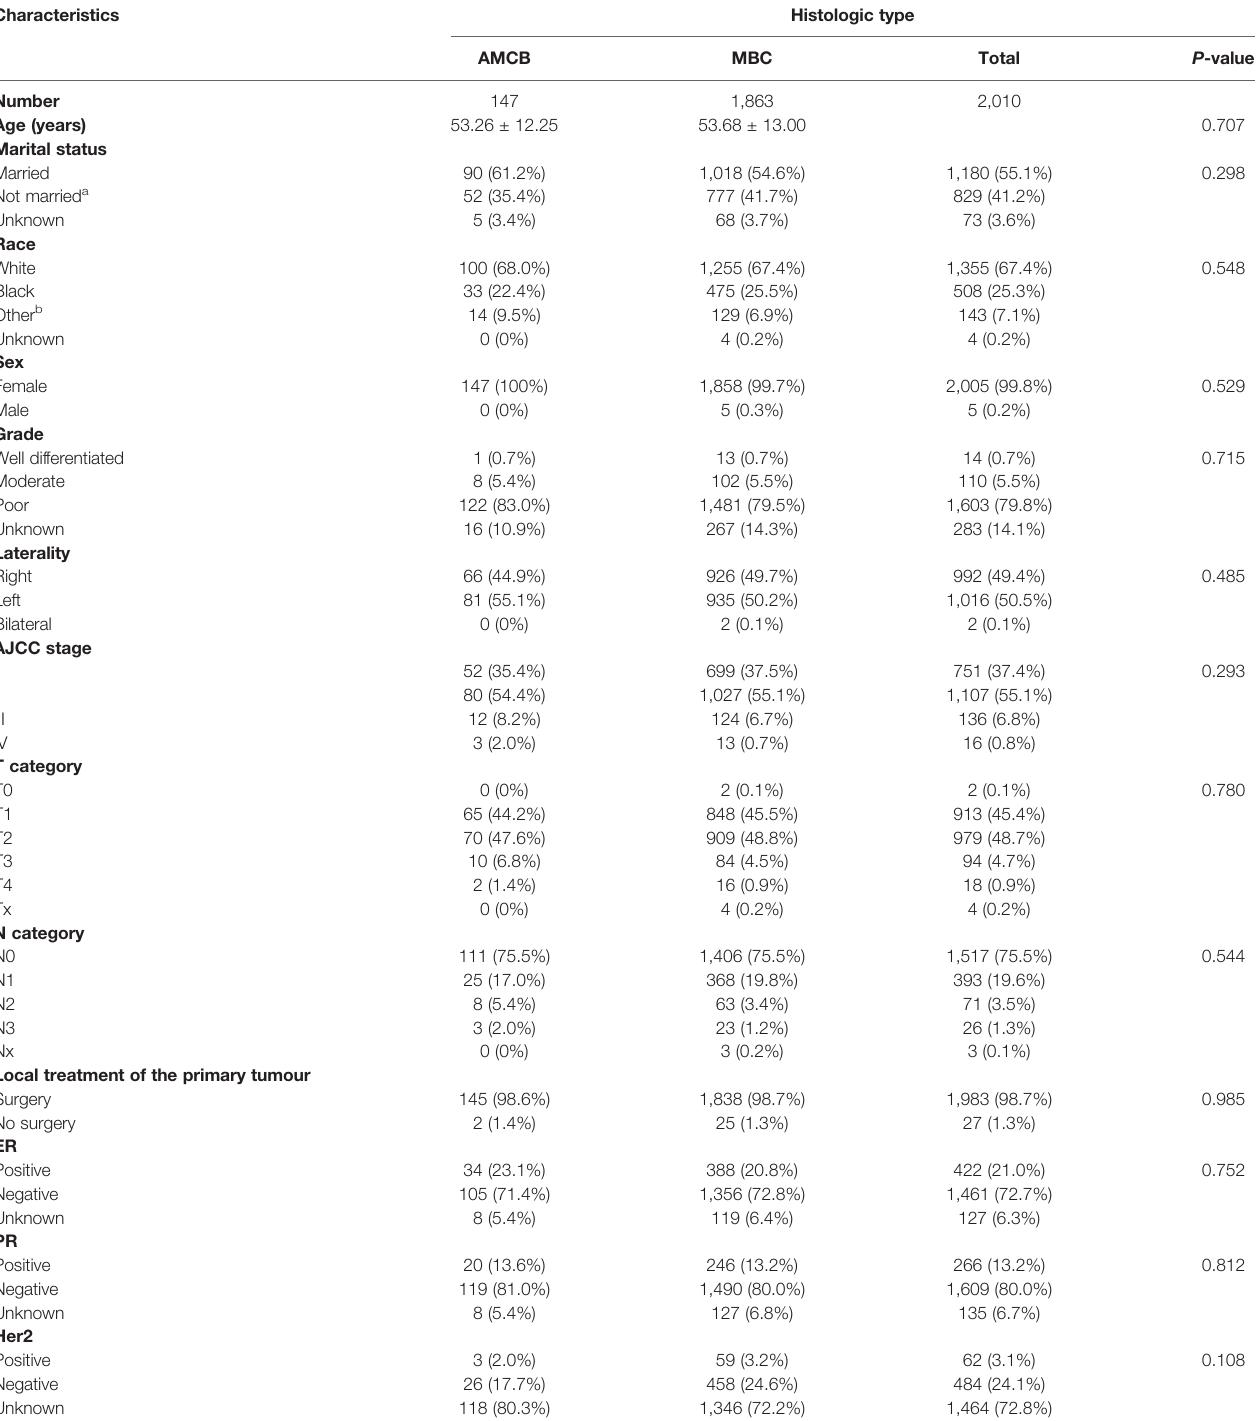
TABLE 1 | Patient characteristics with histologic type of breast cancer in the SEER database, 2004 –